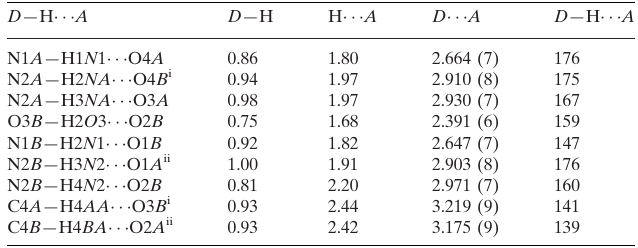
Hydrogen-bond geometry (A˚ , (cid:4) ). D —H (cid:2)(cid:2)(cid:2)